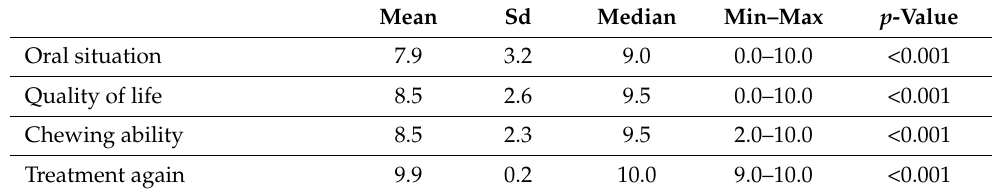
Table 5. Perceived changes at study termination: Numerical rating